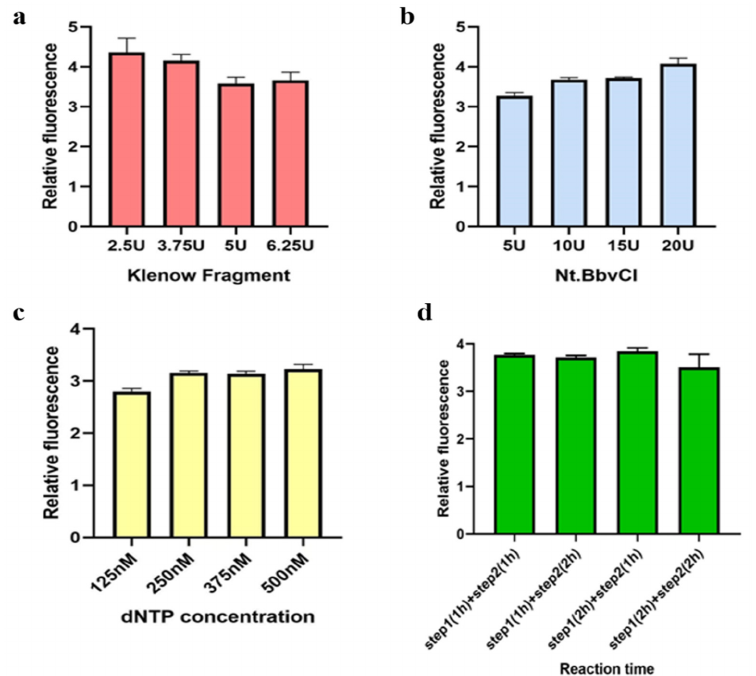
Figure 5. Optimization of the reaction conditions for the detection method of miR-625-5p. ( a ) Opti ‐ mization of the amount of KF polymerase; ( b ) optimization of the amount of Nt.BbvCI; ( c ) optimi ‐ zation of the concentration of dNTPs; ( d ) optimization of the reaction time. The concentration of the other reagents remained unchanged when each reaction condition was optimized. All data are pre ‐ sented as mean ± SD. Each assay was performed in triplicate.